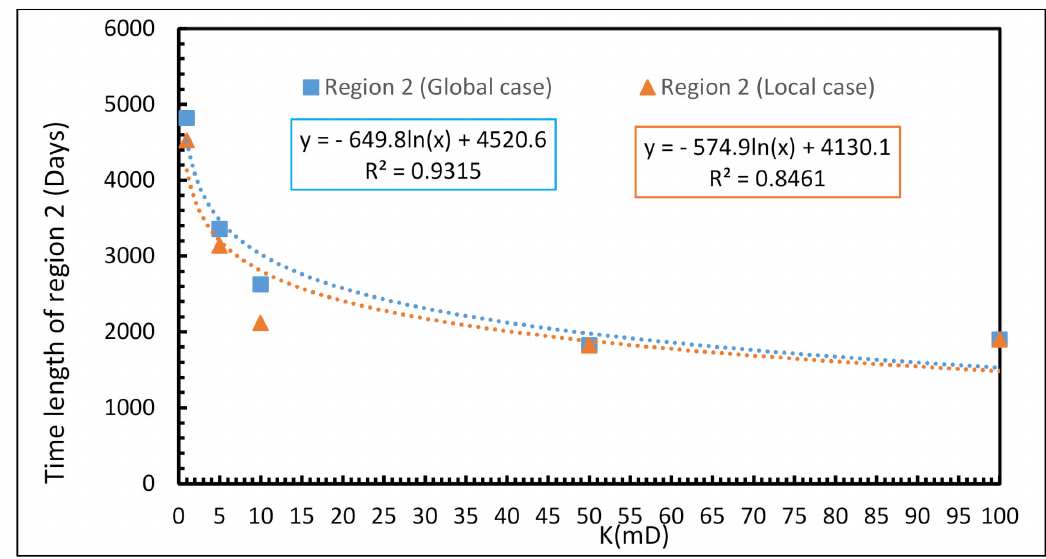
Figure 7. Duration of region 2 as a function of permeability at the wellbore for both analyses.